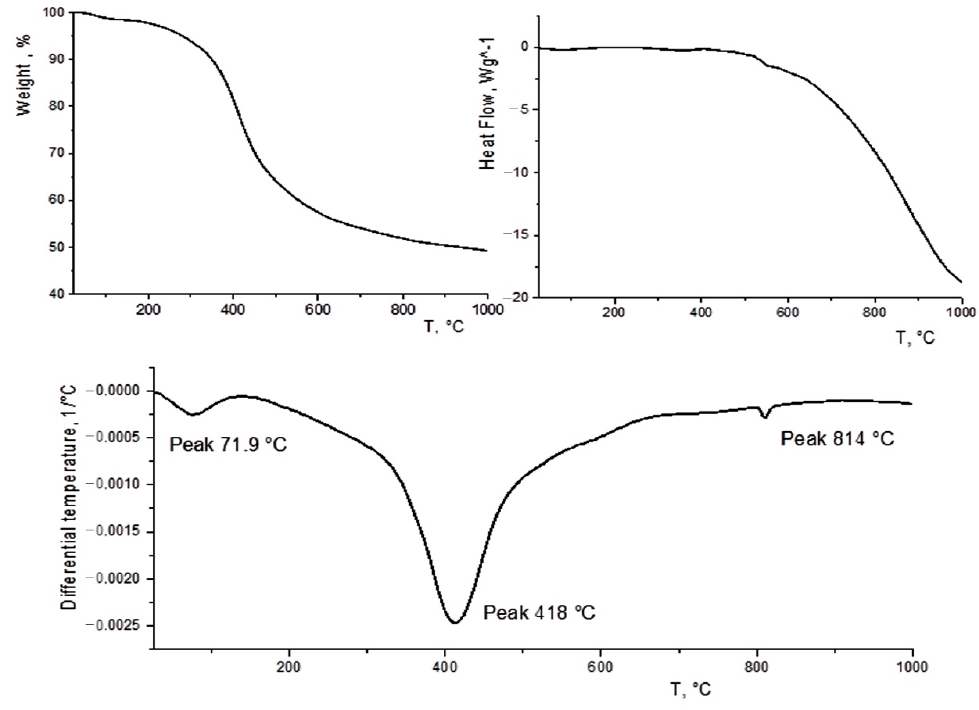
Figure 3. TGA–DTG–DSC data.